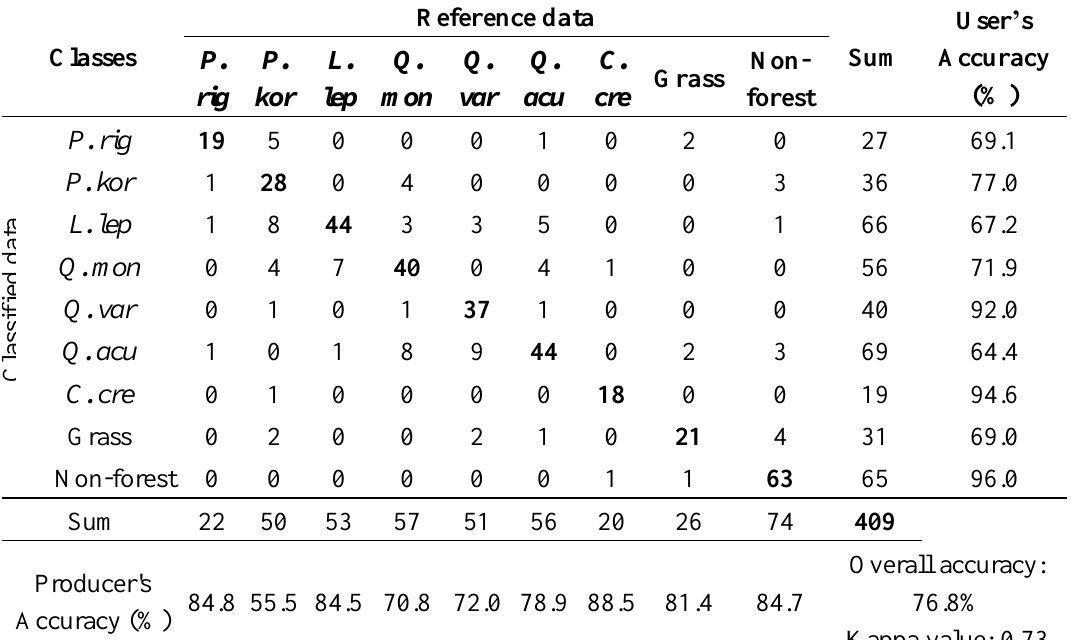
Table 4. Error matrix of segment-based classification (SBC) using a majority rule, with